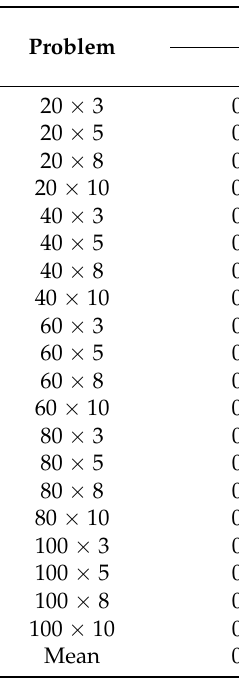
Table 8. C -metric for SDABC and